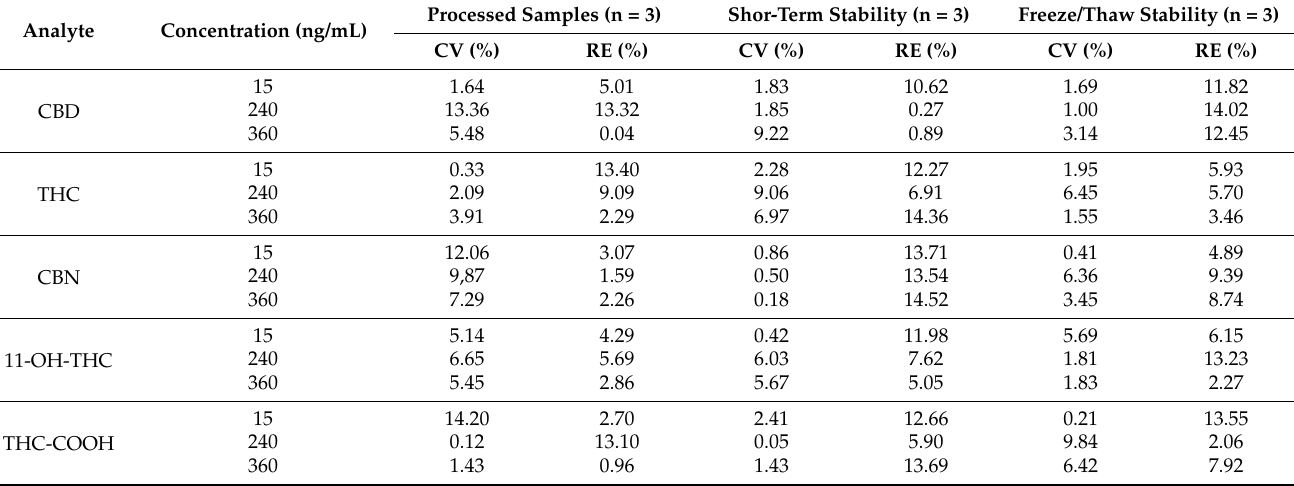
Table 5. Stability evaluation.